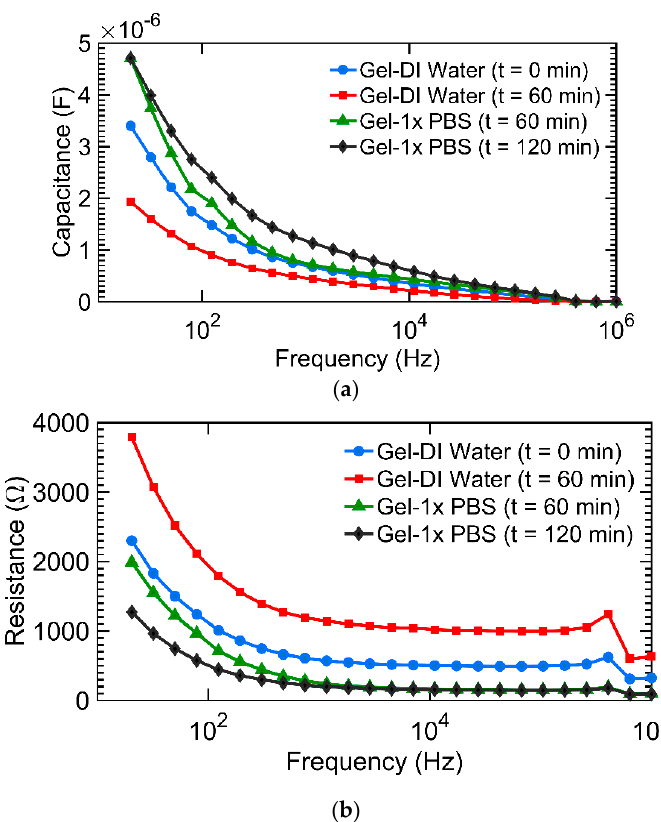
Figure 7. Impedance of the hydrogel-integrated sensor. ( a ) Time-dependent change in capacitance of the hydrogel sensor. ( b ) Time-dependent change in resistance of the hydrogel sensor. It can be seen that phosphate buffered saline (PBS) reduces the hydrogel sensor’s electric resistance and increases hydrogel’s response capacitance.